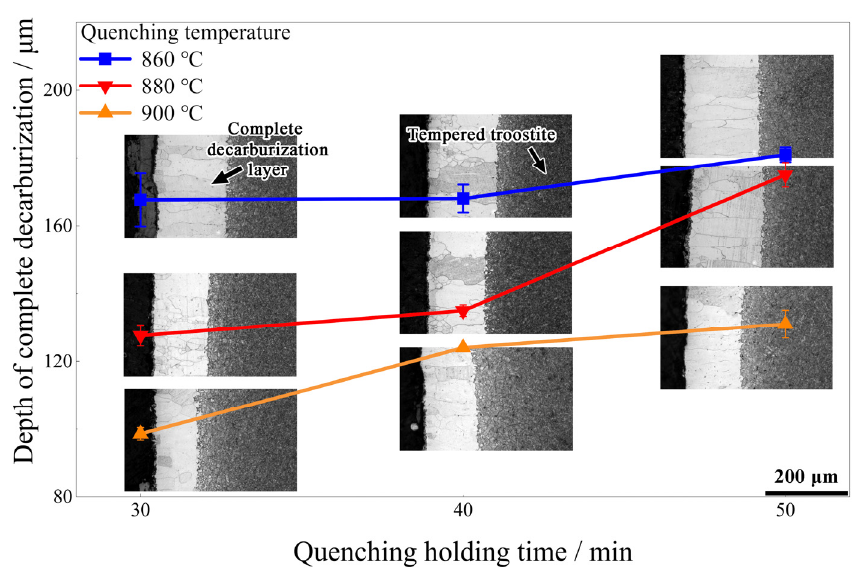
Figure 5. The depth of complete decarburization (DCD) and corresponding decarburization microstructure after heating treatment.